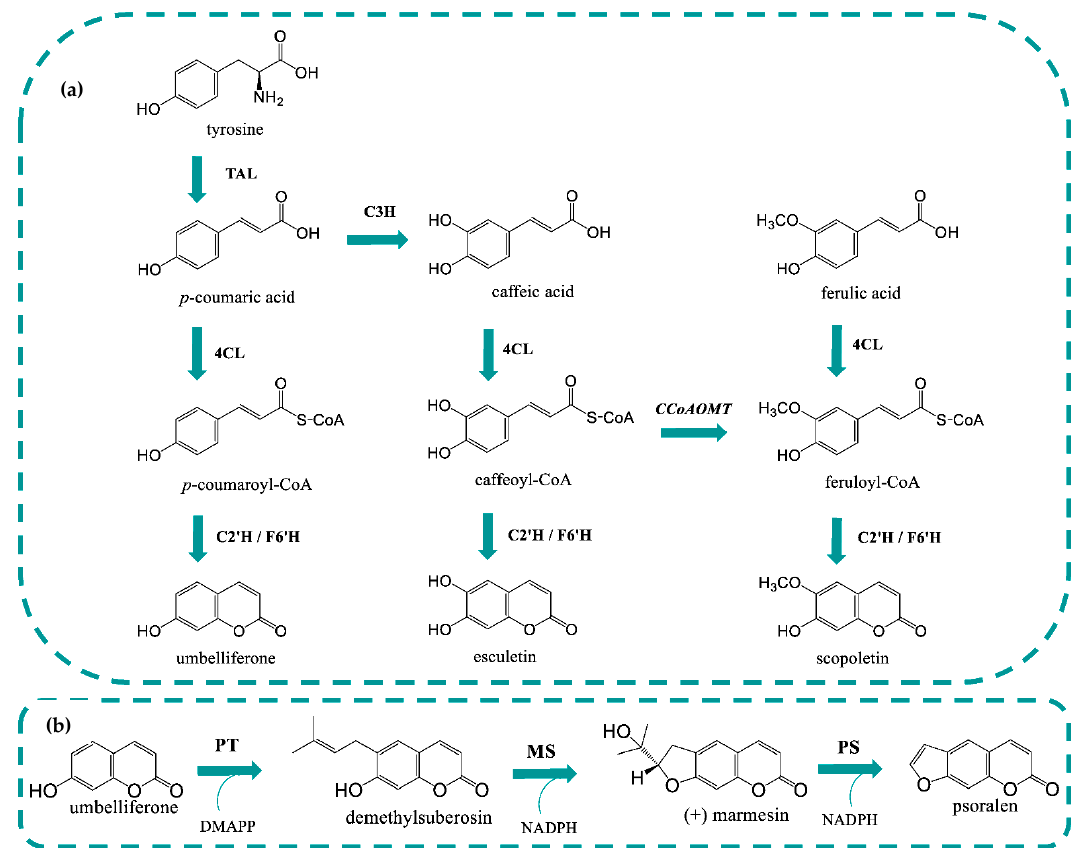
Figure 1. Coumarin’s biosynthetic pathway in Escherichia coli ( a ). Linear furanocoumarin’s pathway in plants ( b ). 4CL1: 4-coumarate-CoA ligase 1; C2 ′ H: p -coumaroyl-CoA 2 ′ -hydroxylase; C3H: 4- coumarate 3-hydroxylase; CCoAOMT: caffeoyl-CoA 3- O -methyltransferase; DMAPP: dimethylal- lylpyrophosphate; F6 ′ H: feruloyl-CoA 6 ′ -hydroxylase; MS: marmesin synthase; NADPH: nicotina- mide adenine dinucleotide phosphate; PS: psoralen synthase; PT: prenyltransferase; TAL: tyrosine ammonia lyase.